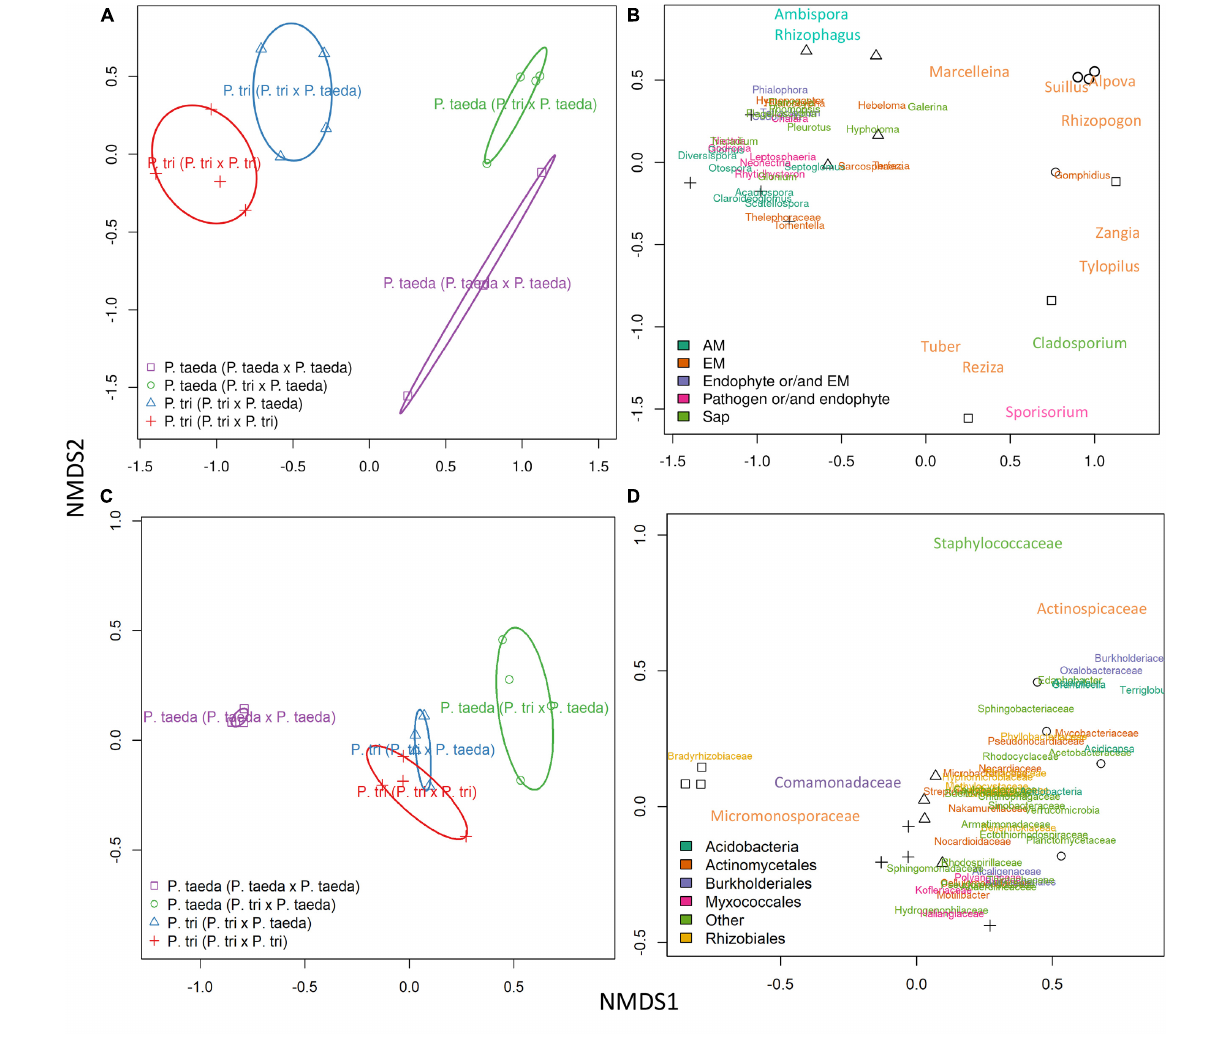
FIGURE 4 | Non-metric multidimensional scaling plots showing the taxonomic composition of different plant host root microbiomes associated with same vs. different neighboring plant species. PERMANOVA was used to determine the changes of fungal (A,B) and bacterial (C,D) taxa associated with neighboring plant species ( Supplementary Table 3 and Supplementary Datasets 2B,D ). AMF, arbuscular mycorrhizal fungi; EMF, ectomycorrhizal fungi; Sap, Saprotrophic fungi. The pairwise comparisons were applied to each microbial taxon ( Supplementary Datasets 2B,D ). P. tri = P. trichocarpa